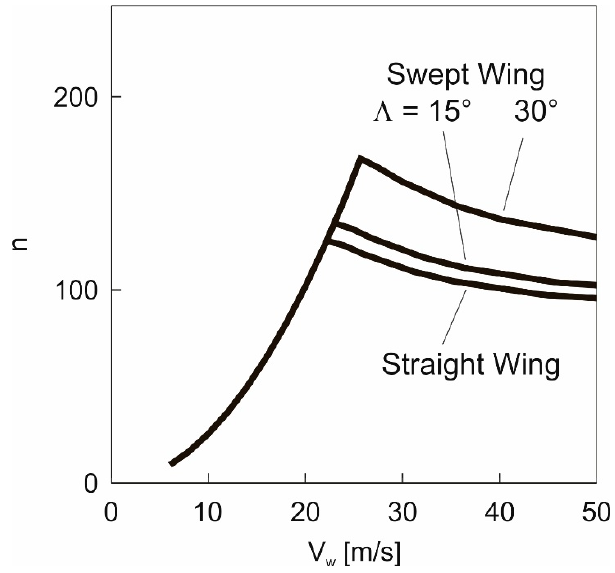
Figure 18. Effect of wing sweep on the load factor for swept wing configuration 1 in maximum-speed dynamic soaring.